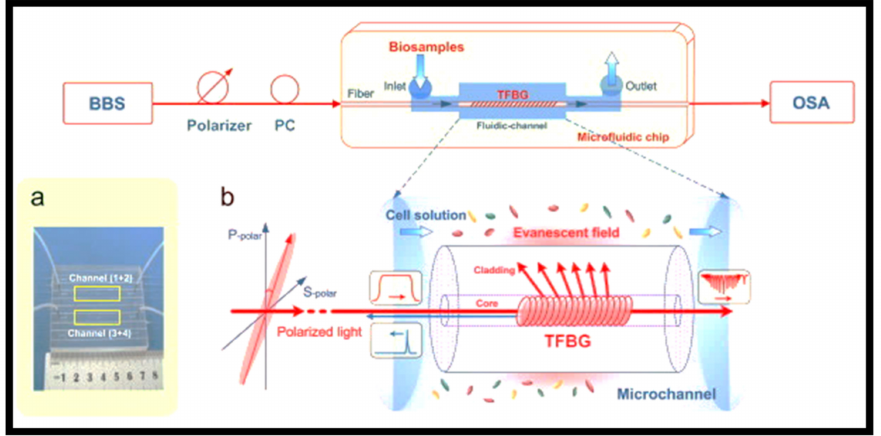
Figure 14. Polarimetric tilted fiber Bragg grating (TFBG) sensing system: ( a ) micro-fluidic chip for biosample measurements. Reprinted with permission from ref. [240]; ( b ) schematic diagram of polarimetric TFBG biosensor interrogated with tunable linearly polarized light. Reprinted with permission from ref.